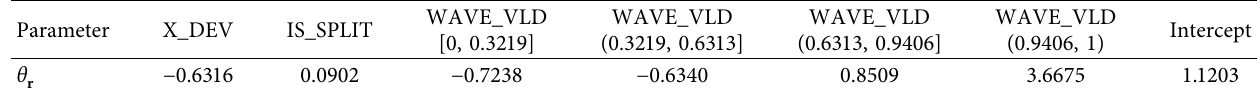
Table 4: Logistic regression classifier parameter model.